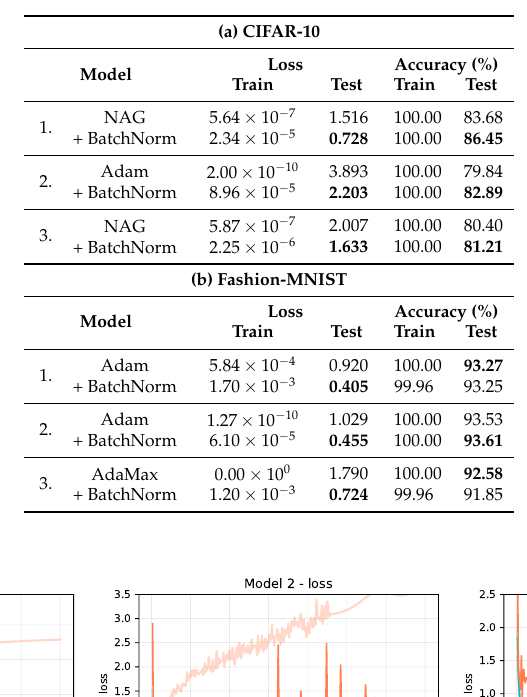
Table 4. Comparison of results obtained with and without Batch Normalization.